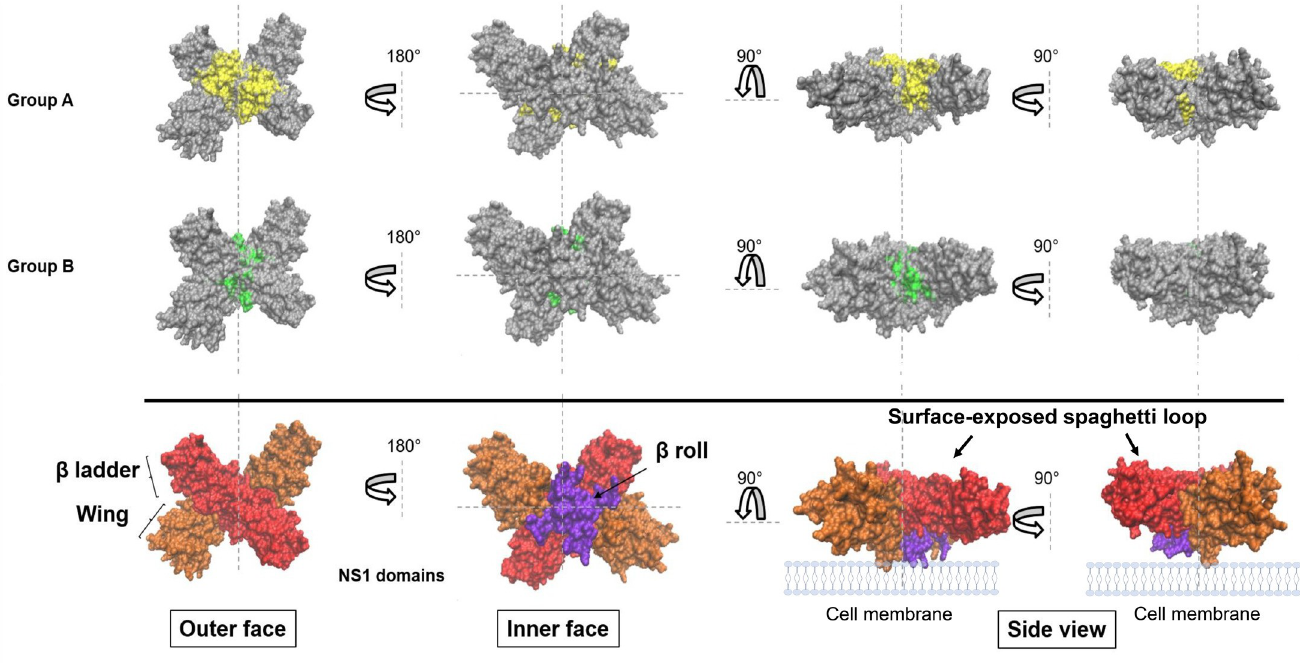
Fig 5. 3D model illustration for the putative recognition sites on DENV2 NS1 structure. The putative binding sites for the mAbs in groups A and B are highlighted in yellow and green, respectively. The NS1 structure is shown as outer and inner faces as well as the side view. NS1 domains including the β -roll (purple), wing (orange), and β -ladder (red) are indicated in the NS1